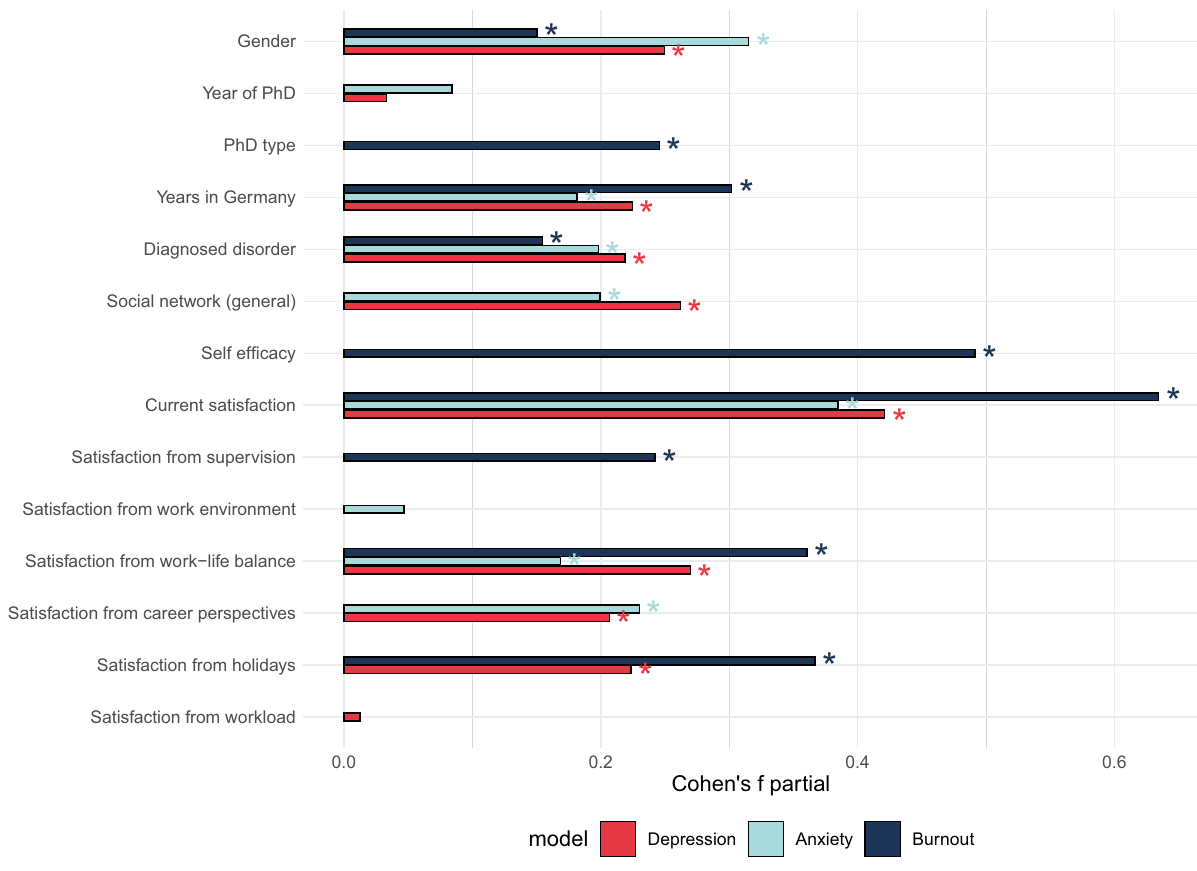
Figure 7. Effect sizes (Cohen’s partial f ) in the exploratory models of depression, anxiety, and burnout. The asterisks mark predictors for which the main effects reached statistical significance ( p <